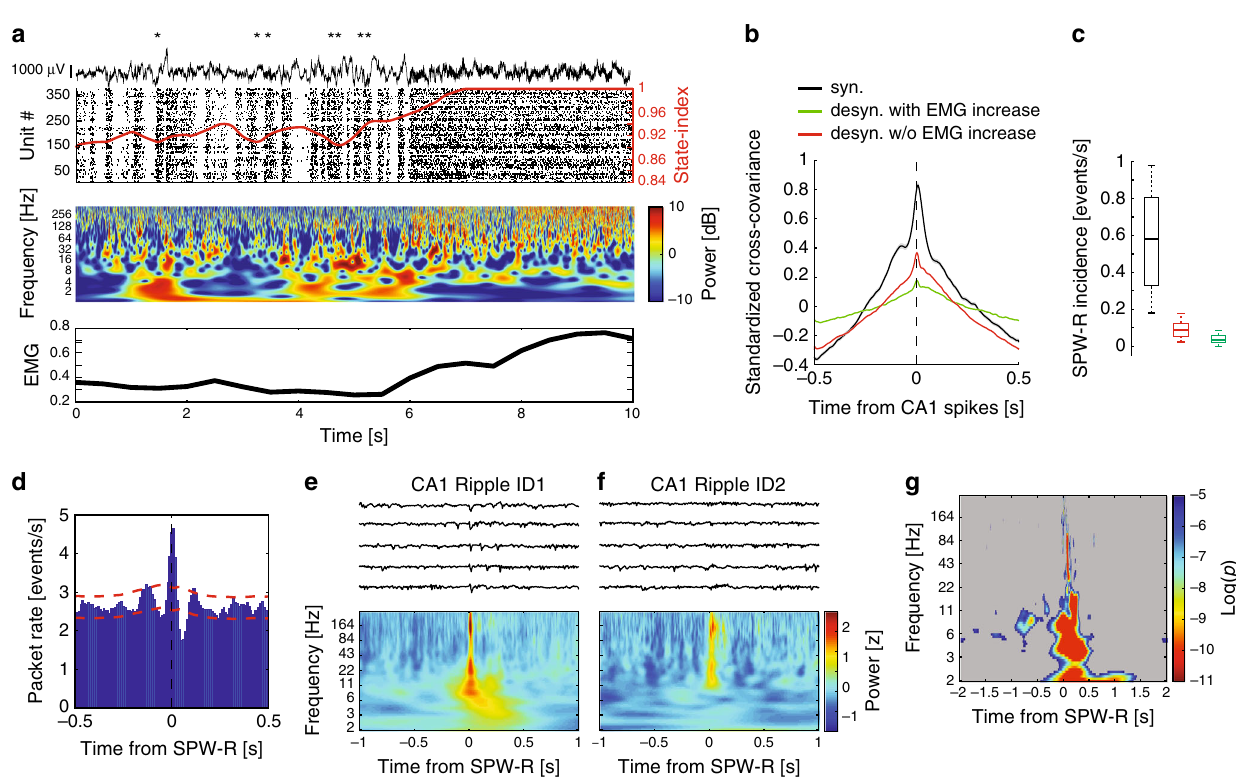
Fig. 6 Hippocampal-gRSC communication is state dependent. a Top panel: example of 10 s gRSC LFP (top), spiking activity (bottom) and the corresponding state-index (red) showing state transition from a synchronized to a desynchronized state. Asterisks, SPW-Rs detected in CA1. Middle panel: Wavelet spectrogram of the LFP trace shown above. Note the absence of low frequency activity in the desynchronized state and the alternating high- frequency activity in the synchronized state re fl ecting population bursts. Bottom panel: corresponding EMG activity. See also Supplementary Fig. 7. b Standardized cross-covariance between dorsal CA1 and subiculum and gRSC unit pairs taken from synchronized (black) and desynchronized regimes either with (green) or without (red) increase in EMG activity ( n = 12 sessions from fi ve animals and 19,064 unit pairs). See Supplementary Fig. 7. c SPW-R rate is reduced during desynchronized compared to synchronized regimes. Data are displayed as box plot representing median, lower and upper quartiles and whiskers representing most extreme data points ( n = 10 sessions from four animals). d Cross-correlogram between hippocampal SPW-Rs and gRSC activity packets ( n = 14 sessions from three CaMKII::Ai32 and four VGlut2-Cre mice, 8924 SPW-Rs and 87,820 packets). e Top: Example LFP traces from most super fi cial and posterior gRSC electrode time locked to the onset of CA1 ripple cluster ID1. Bottom: Mean spectrogram for cluster ID1. f Same as ( e ) for ripple cluster ID2. g The degree to which the power of each frequency band at each lag around ripple onset distinguishes ripple cluster ID. Non- signi fi cant areas are shown in gray. Corrected for multiple comparisons at each time ( p < 0.0004, ANCOVA test with Bonferroni